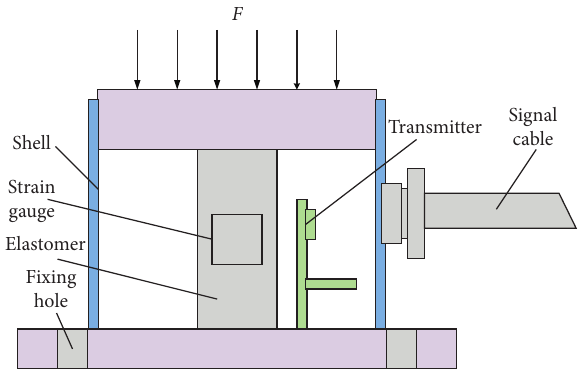
Figure 13: Structure of pressure